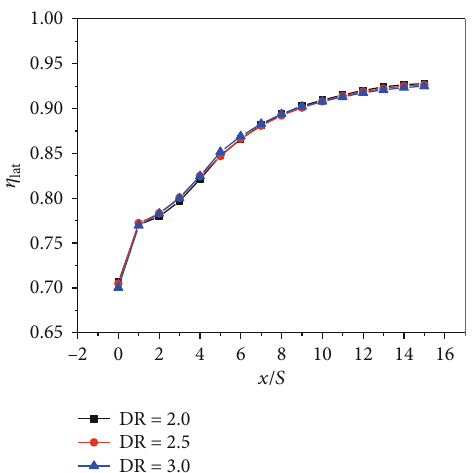
Figure 13: In fl uence of density ratio on cooling e ffi ciency